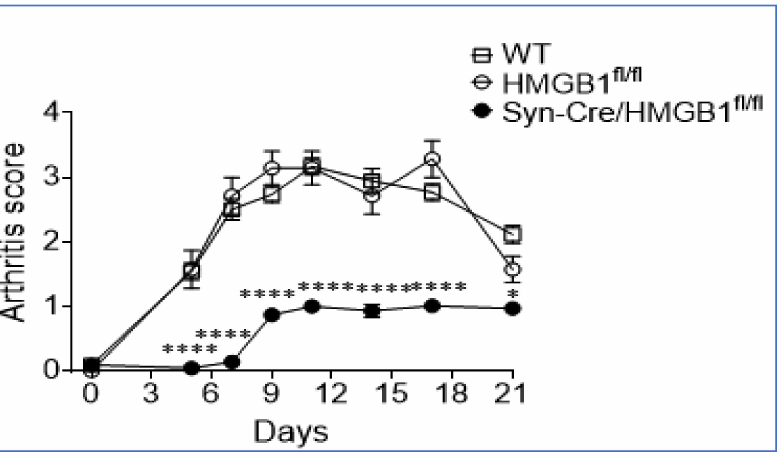
Sensory neurons, termed “nociceptors” mediate neuroinflammation through the ret- rograde or “antidromic” release of neuropeptides, neurotransmitters, and incompletely defined mediators. Recently we reported that HMGB1 is a necessary and sufficient media- tor of neuroinflammation because nociceptors harvested from transgenic mice expressing channelrhodopsin-2 (ChR2) directly release HMGB1 when stimulated by light [35]. In collagen antibody-induced arthritis in mice, ablation of neuronal HMGB1 decreased hyper- algesia, delayed onset, and reduced intensity of joint inflammation and cartilage destruction compared to wild type (WT) or HMGB1 floxed ( HMGB1 fl/fl ) control mice (Figure 7).